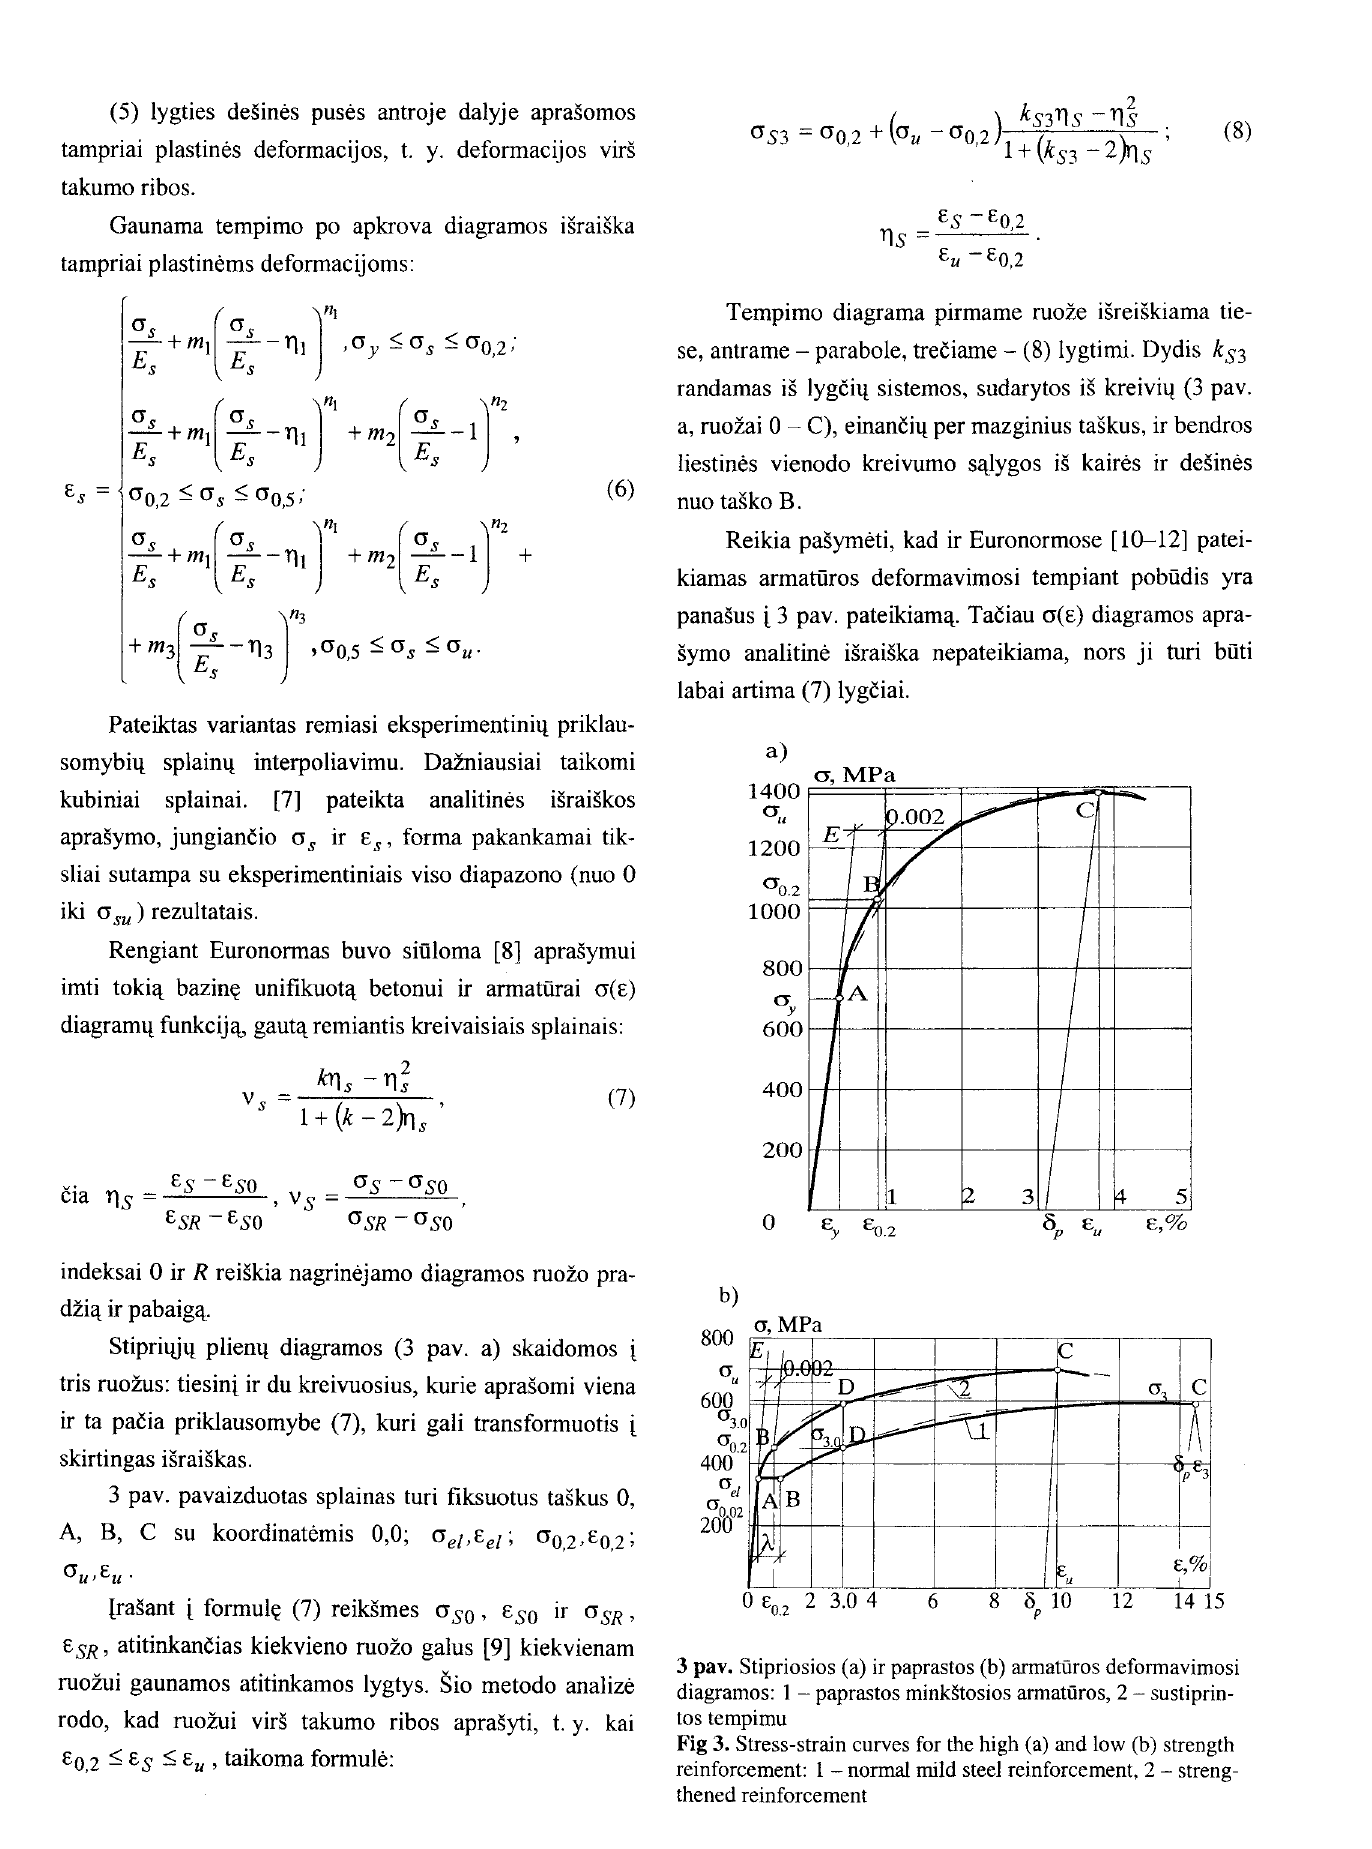
diagramos: 1 - paprastos minkstosios armatUros, 2 - sustiprin tos tempimu Fig 3. Stress-strain curves for the high (a) and low (b) strength reinforcement: 1 -normal mild steel reinforcement, 2- streng thened